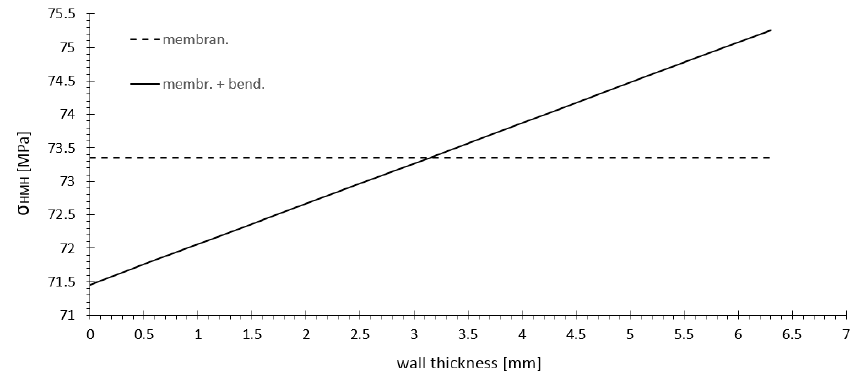
Figure 9. Linearized equivalent stress (HMH) after 200,000 h ( T = 665 ° C).